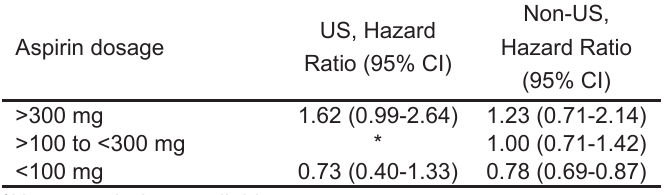
Table 4: Primary efficacy outcome, US vs non-US.